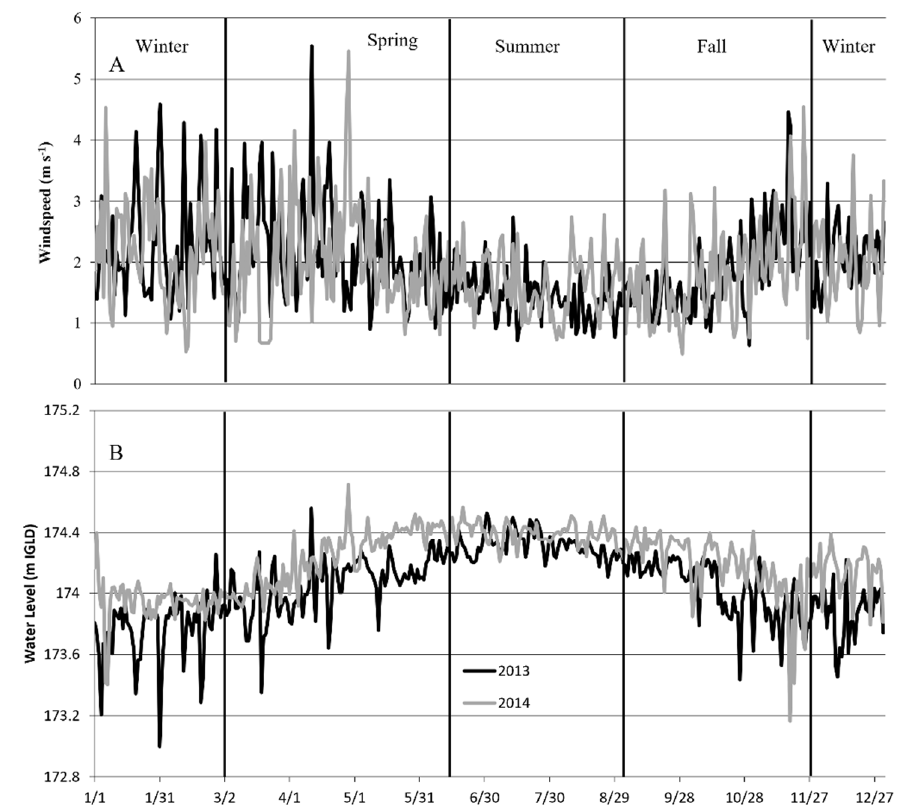
Figure 4. Lake Erie mean daily ( A ) wind speed (m/s) and ( B ) water level (m above IGLD85) at Toledo, OH. See text for date ranges of seasons. Lake-level data were downloaded from http://tidesandcurrents.noaa.gov/ (Station no. 9063085) accessed 1 December 2017.